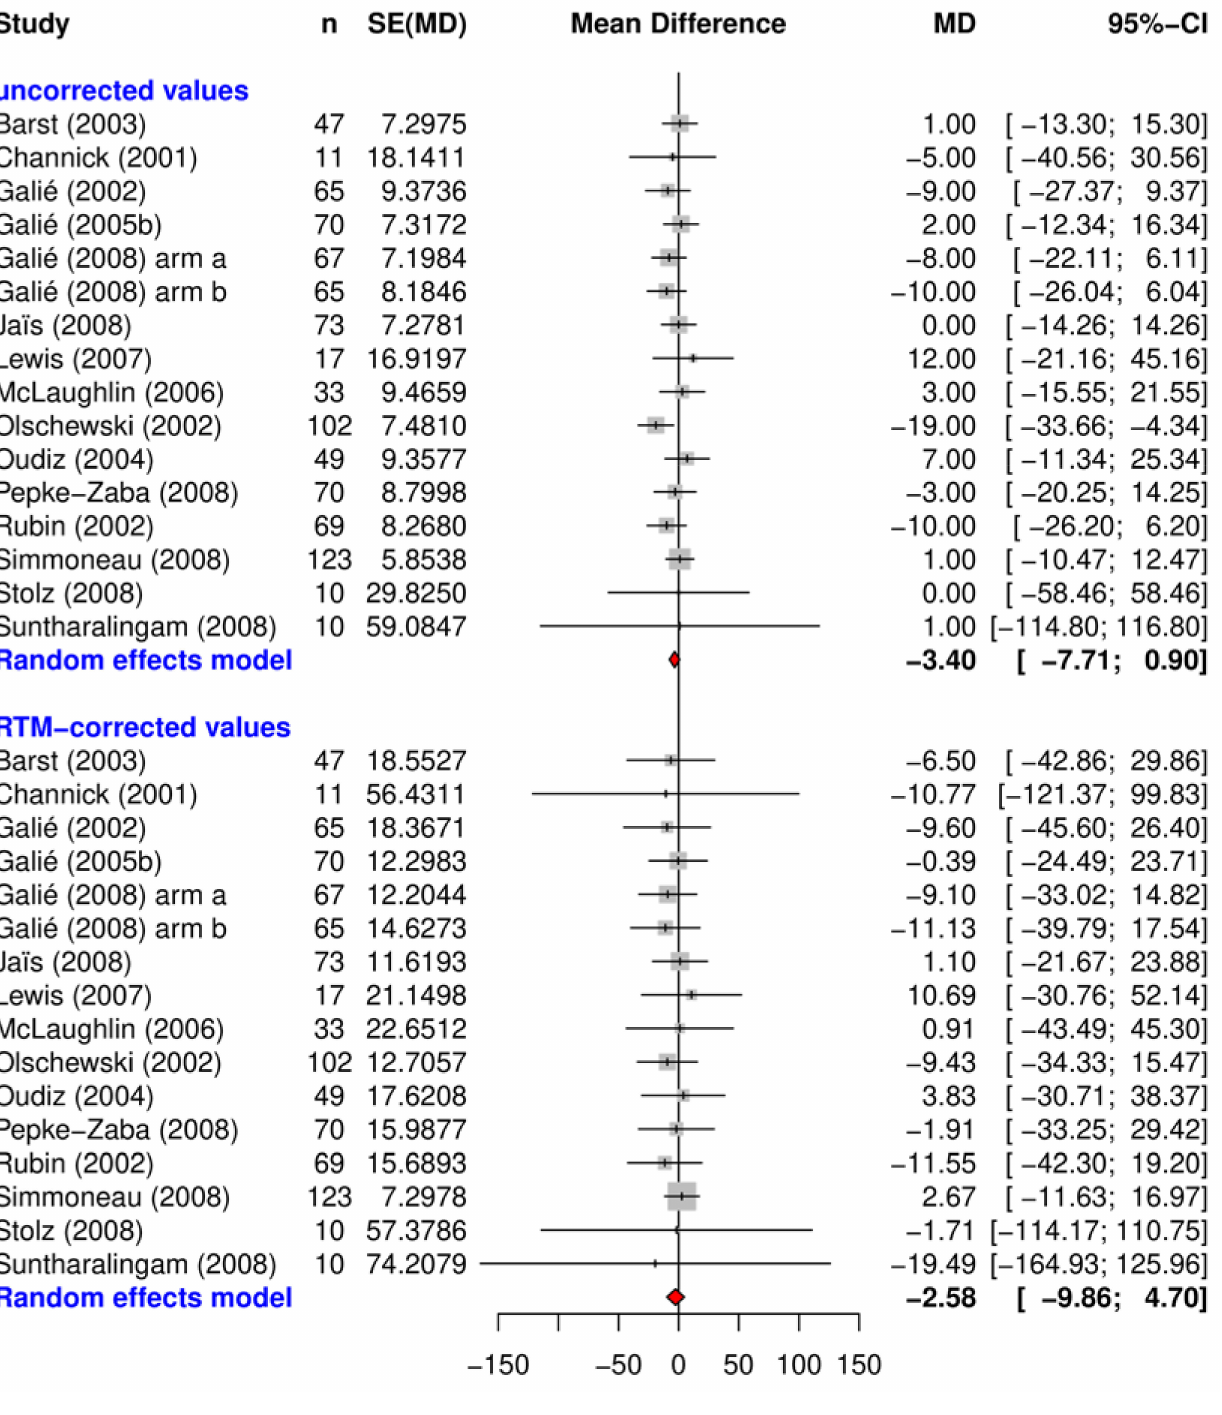
Figure 2. Uncorrected and RTM-corrected treatment effects measured with the 6MWD after 12 weeks from the placebo arms. Abbreviations: n = number of participants in study (arms); seTE = standard error of treatment effect; MD = mean difference; 95% CI = 95% confidence in- terval. Note: the difference in numbers between the placebo and the verum group in Figures 1 and 2 can be explained by the fact that many studies compared several treatment groups to only one single placebo